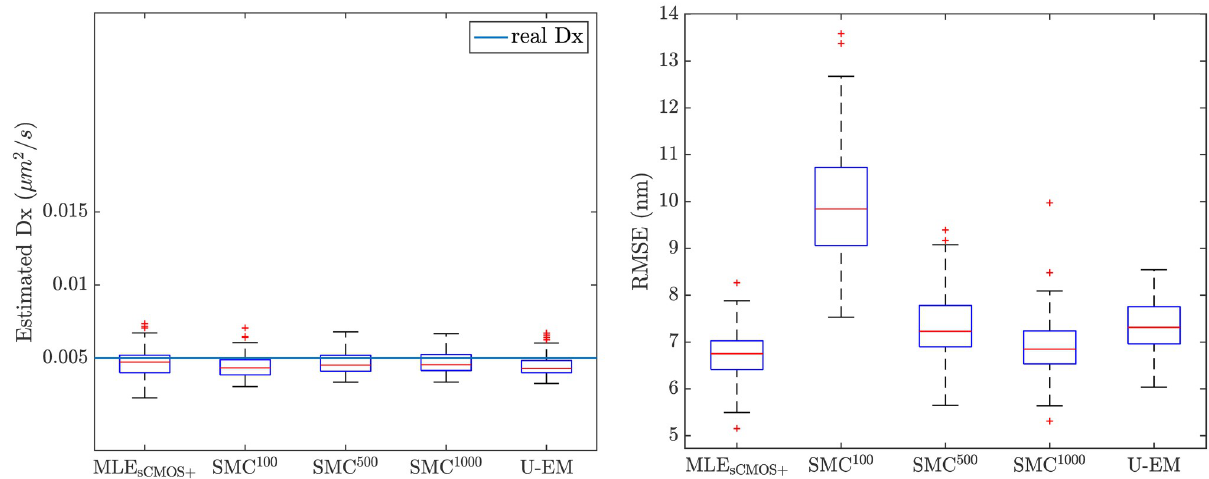
Fig 14. Estimation performance of different SPT methods on sCMOS camera model at G = 100 and N